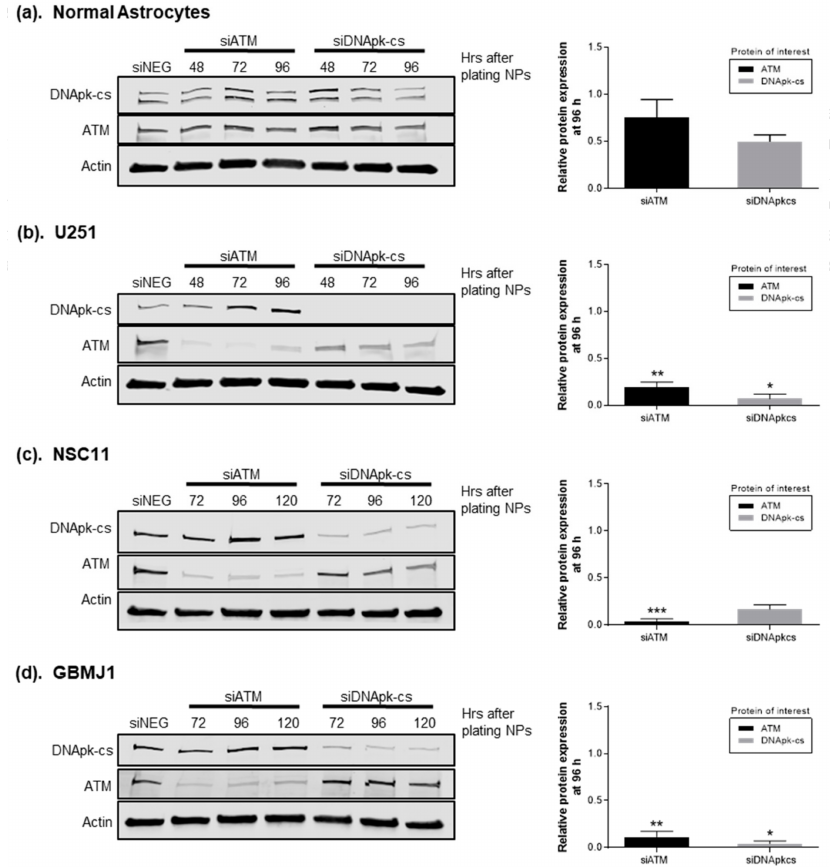
Figure 2. Silencing of target genes via RGD-PEG labeled ECO nanoparticles (NPs) carrying ATM and DNApk-cs